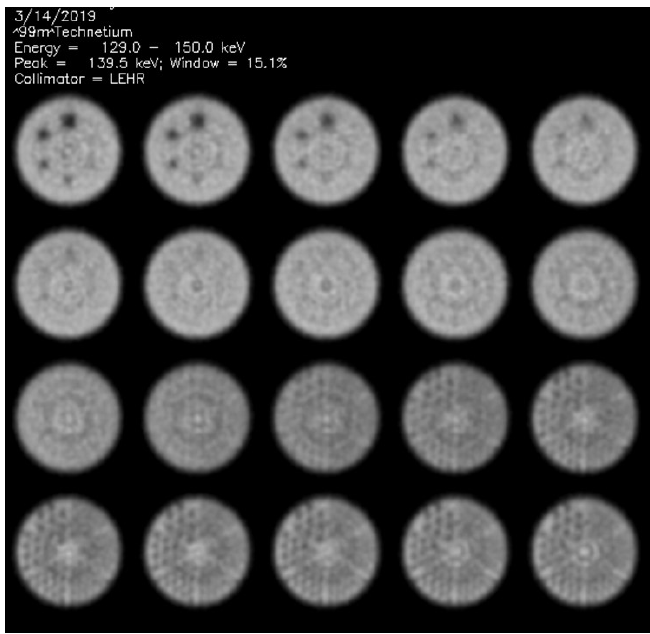
Figure 2. Example of images related to the spheres sections and rod sections of a phantom, whichboth readers scored “4”, forsevere concentric ring artifacts, in both sections.